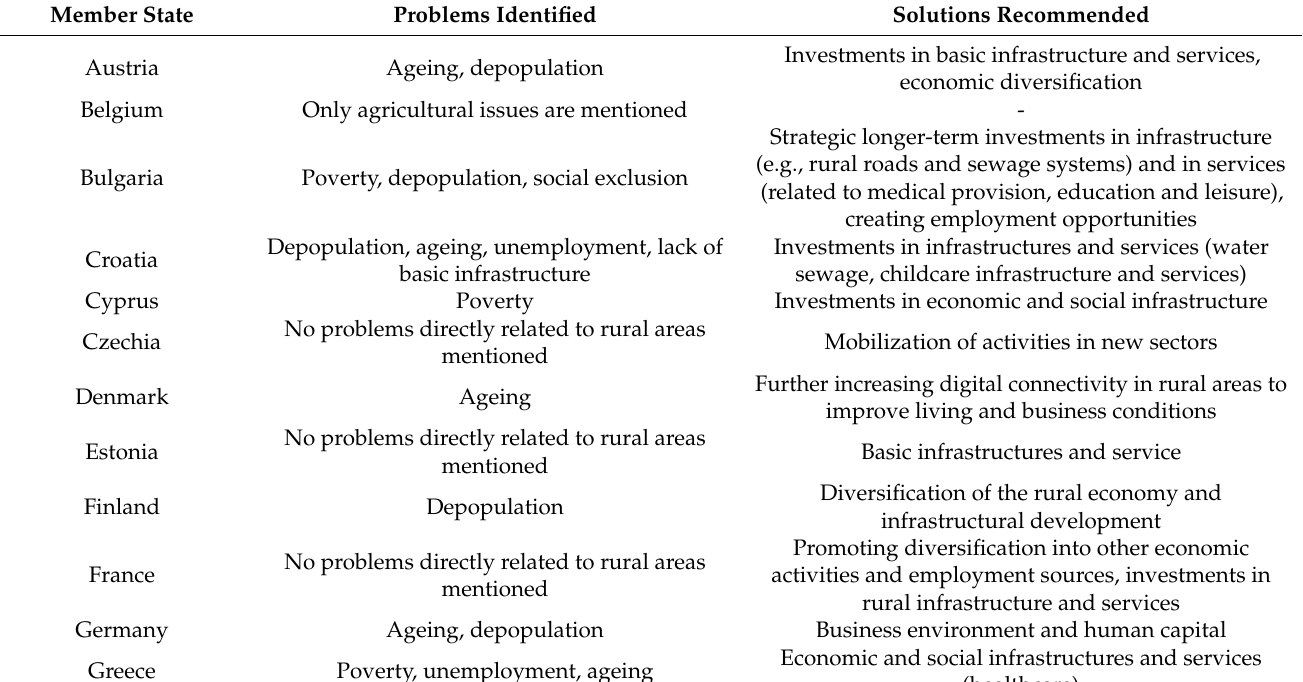
Table 2. European Commission’s recommendations for rural development focus in CAP strategic